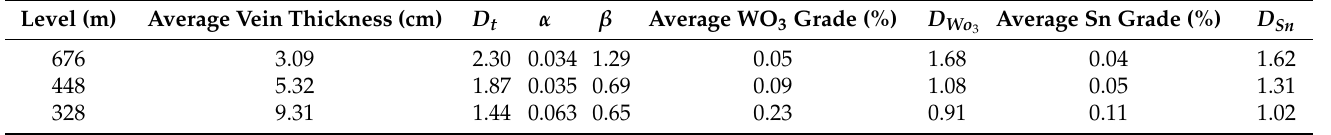
Table 1. Statistical data of vein thickness and ore grade at different